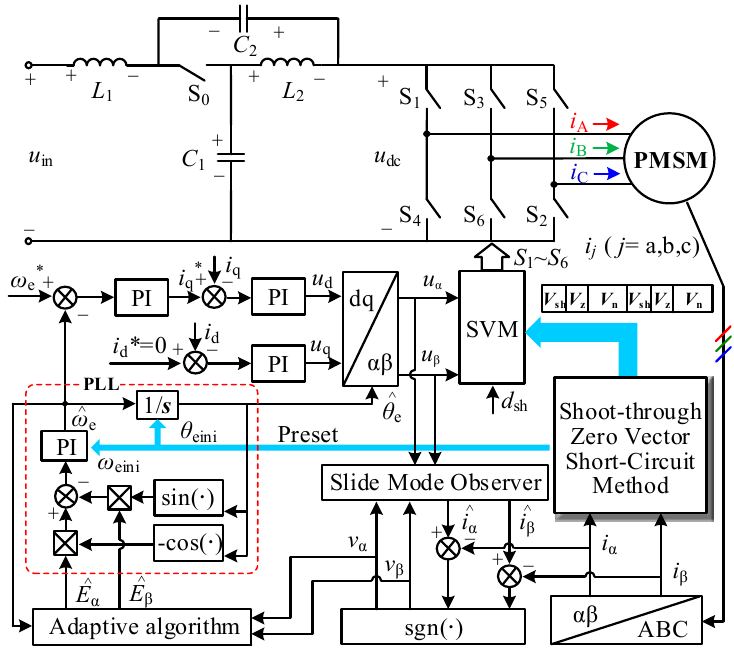
Figure 8. Diagram of sensorless flying restart control scheme based on the proposed SZVSM.